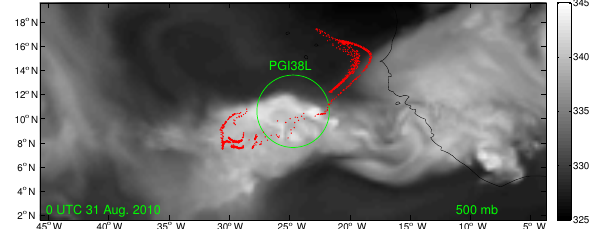
Figure 8. Particle trajectory locations at 500hPa 18:00UTC 31 Au- gust are overlaid on θ e (K) 00:00UTC 31 August 2010. These tra- jectories are all within a radius of 3 ◦ of the pouch center (green circle) by 18:00UTC 2 September.